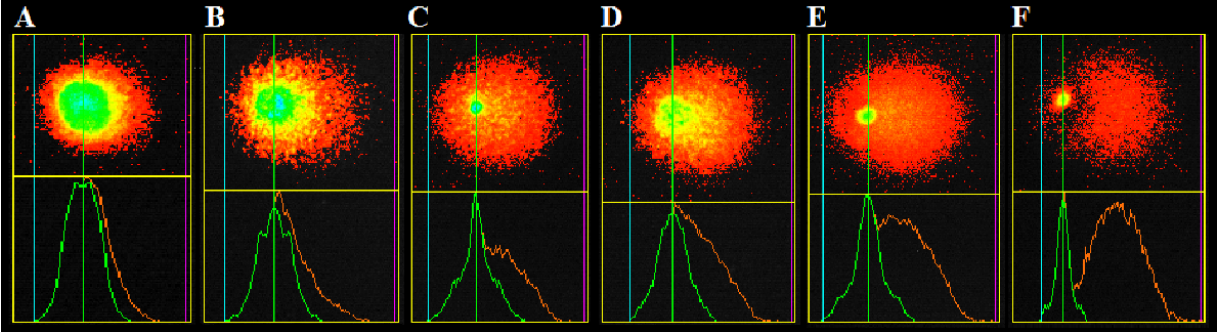
Figure 8. Representative images of nucleoids scored in comet assay, with different levels of TI%: ( A )—18.97%, ( B )—29.94%, ( C )—38.08%, ( D )—46.58%, ( E )—56.74%, and ( F )—78.28%.